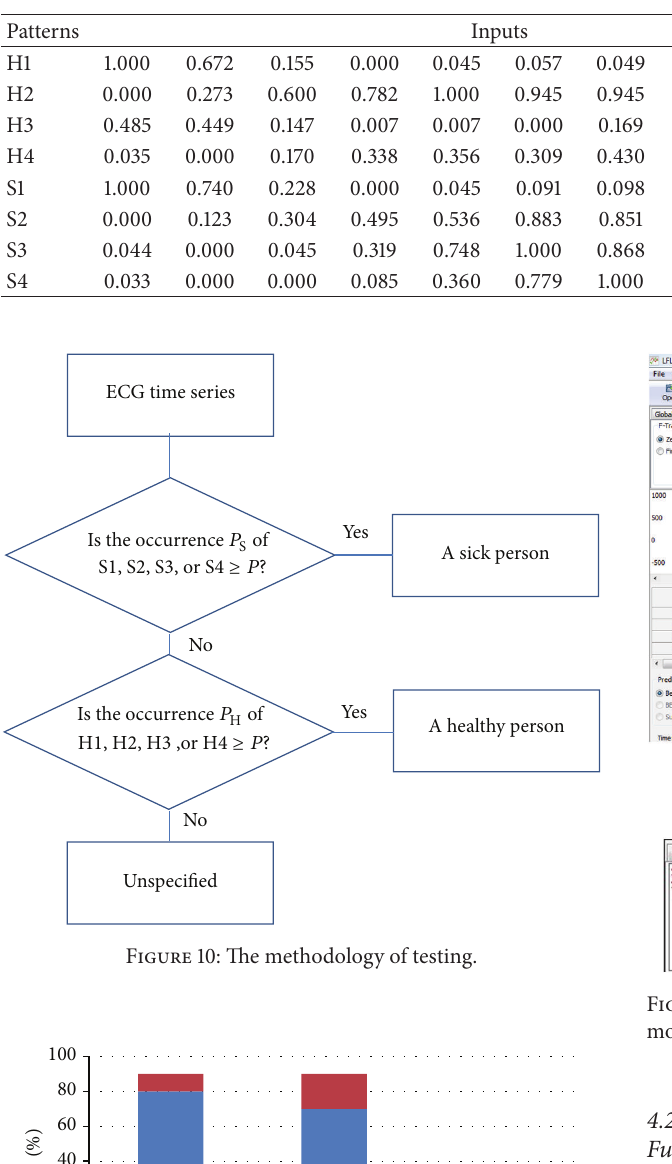
Table 1: The training set.